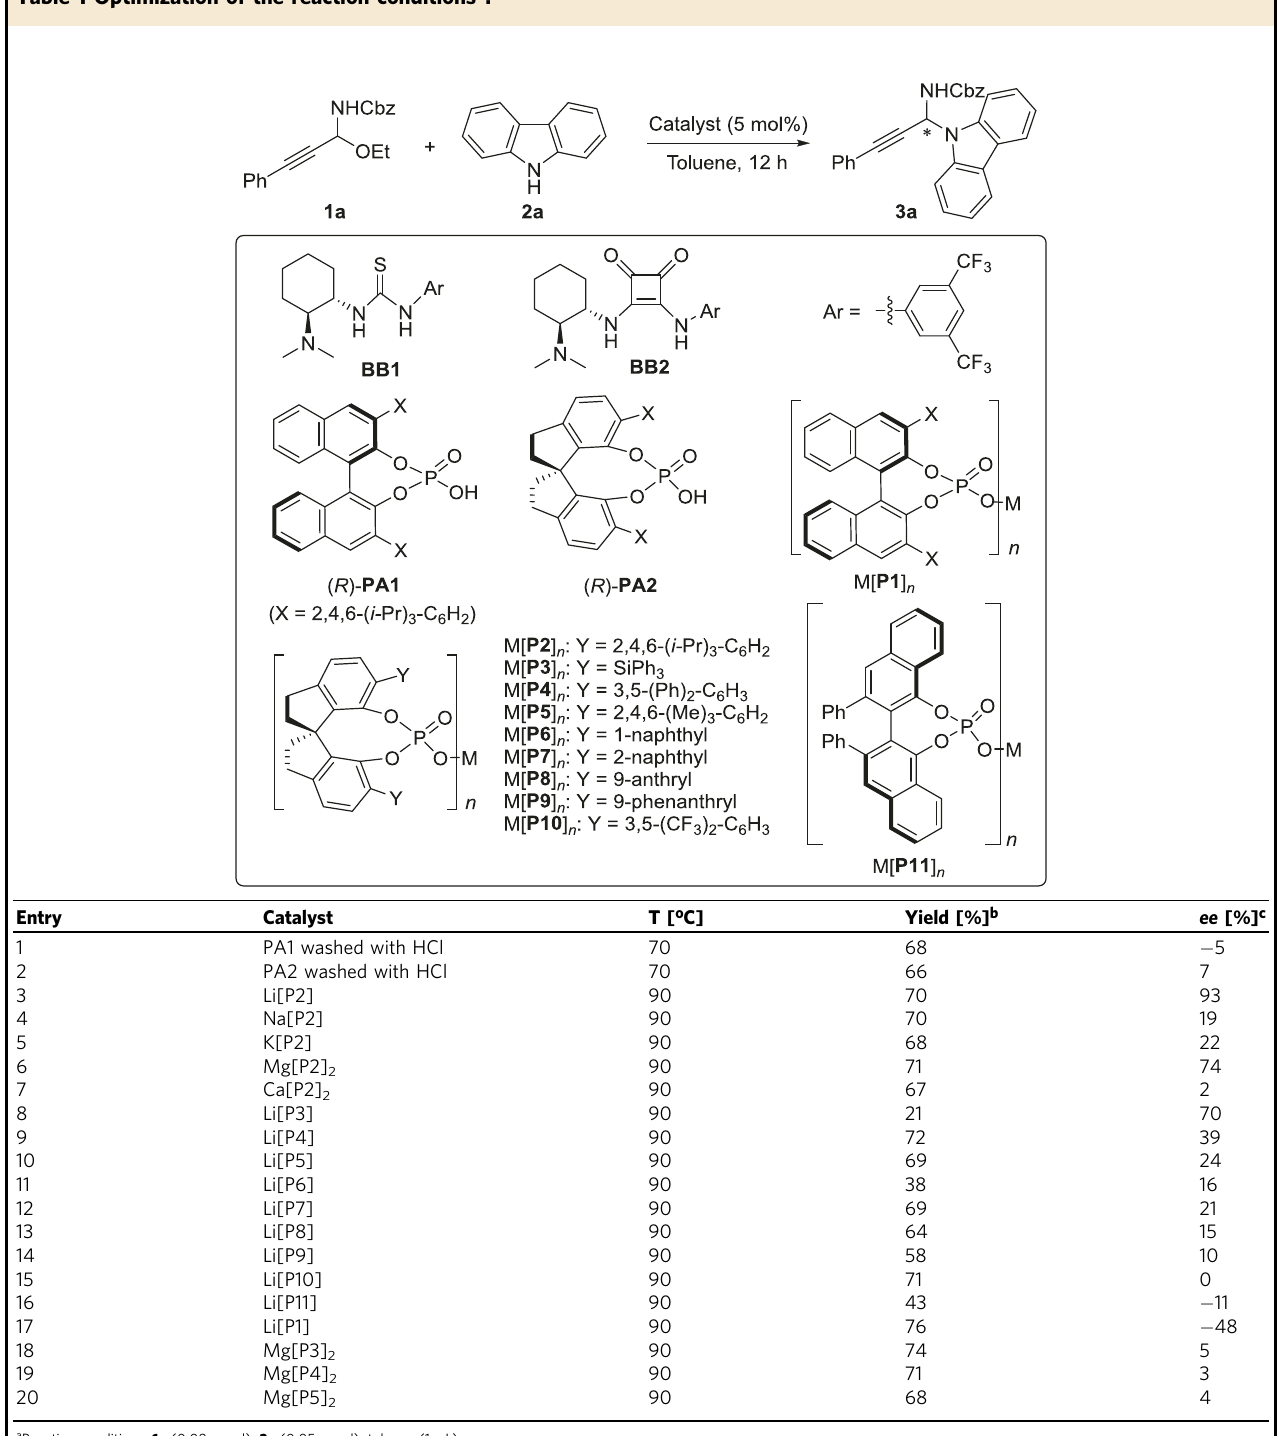
Table 1 Optimization of the reaction conditions a